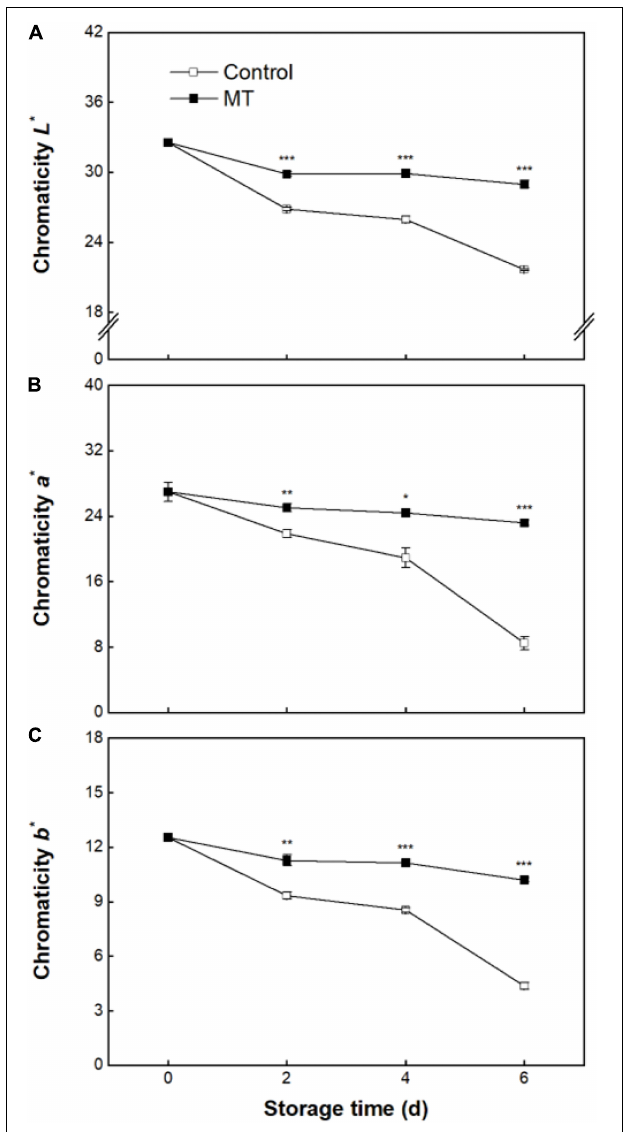
FIGURE 2 | Chromaticity L * (A) , a * (B) , and b * (C) in “Baoyan 7” rambutan fruit during storage at 25 ◦ C after treatment with 0.125 mmol L − 1 MT or water (control). The vertical lines represent the SE of triplicates while the asterisks indicate significant